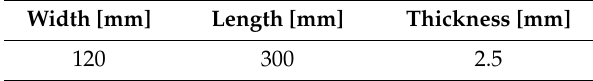
Table 2. The test piece dimension for experiments.